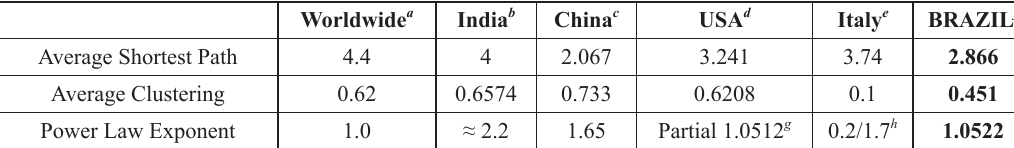
Metrics of different Air Transportation Networks.